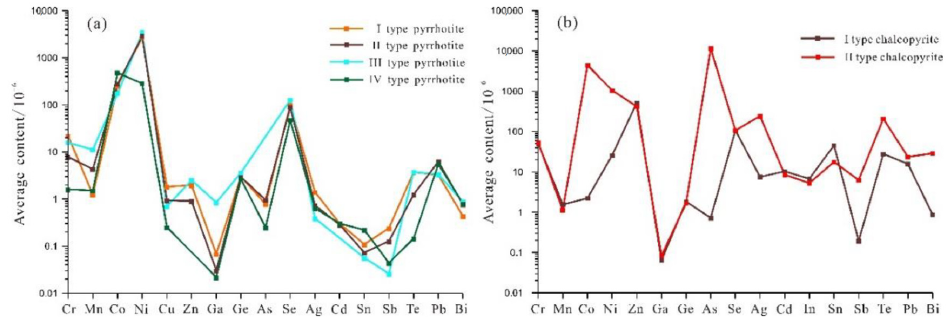
Figure 6. Comparison of the trace element compositions of pyrrhotite and chalcopyrite in the Huangyangshan deposit; ( a ) the trace element compositions of four types pyrrhotite; ( b ) the trace element compositions of two types chalcopyrite. Table 2. Trace element analysis results of pyrrhotite in Huangyangshan deposit (ppm).